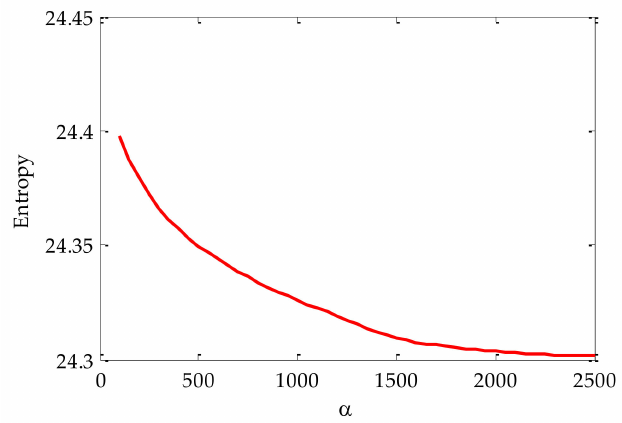
Figure 8. Curve of fitness varying with α value.